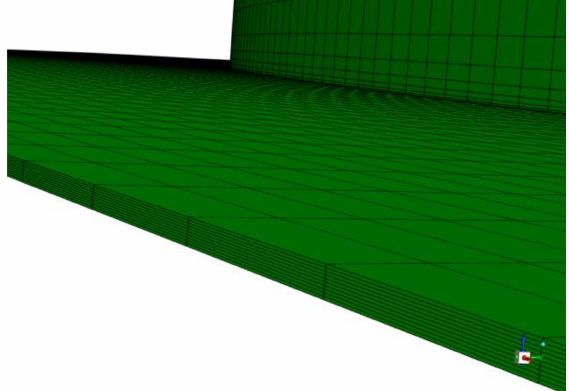
Figure 3. Structured grids of the computational